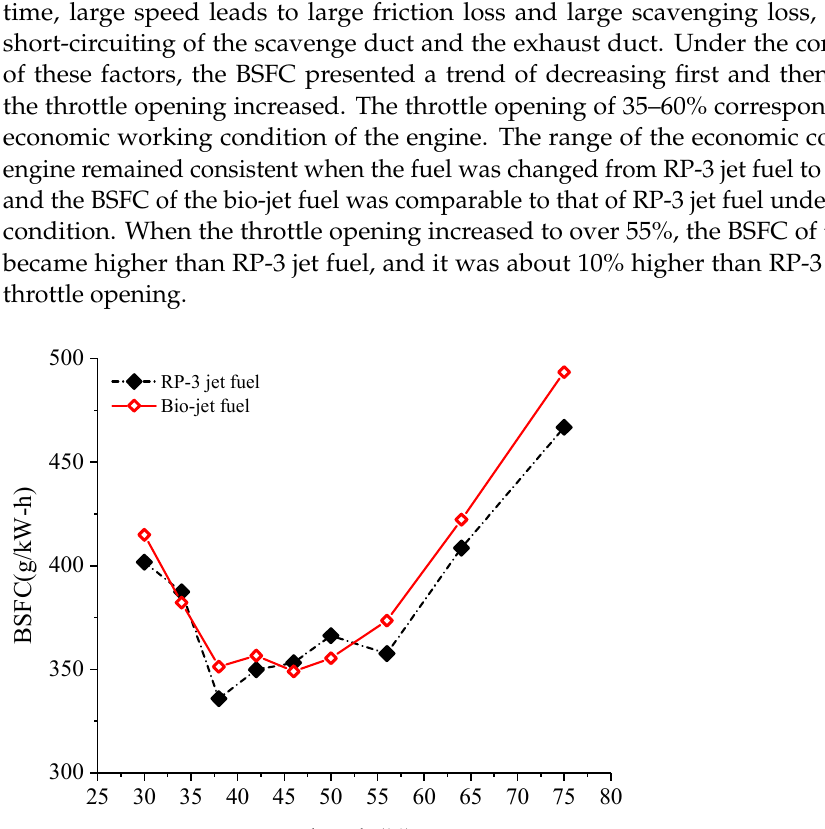
7 of 13 Figure 6. Variation of brake power and speed against throttle opening.